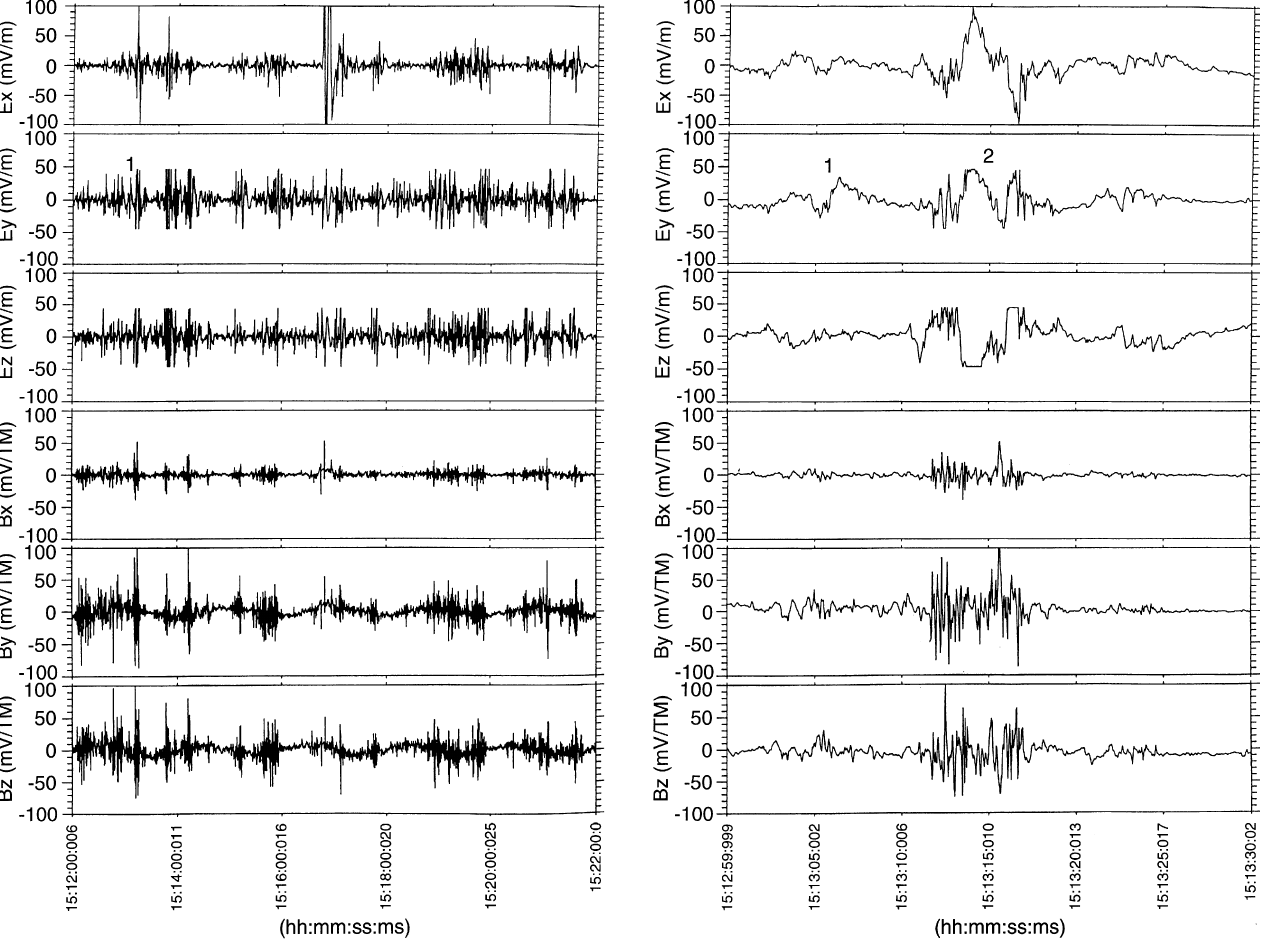
Fig. 4. Same as Fig. 1 for the event displayed in Plate 2. The intensification of the waves occurs simultaneously on the six components. The emission consists of successive wave packets more or less regularly spaced. The strong signal at (cid:24) 15:16:30 UT is due the calibration of NVKONCH